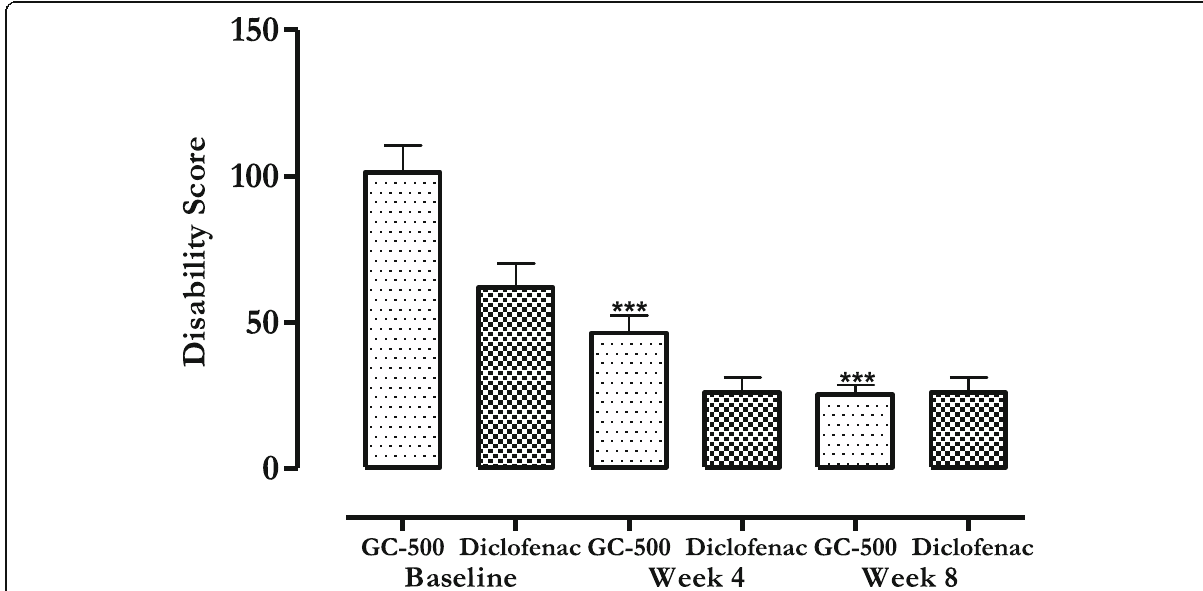
Fig. 4 The effect of GC-500 on the Disability Score of participants compared to Diclofenac. Data is expressed as Mean ± SD. A non-significant difference was observed between the groups p > 0.05 after ANOVA and Bonferroni post-hoc test . *** p < 0.001: GC-500 at Week 4 & 8 compared to